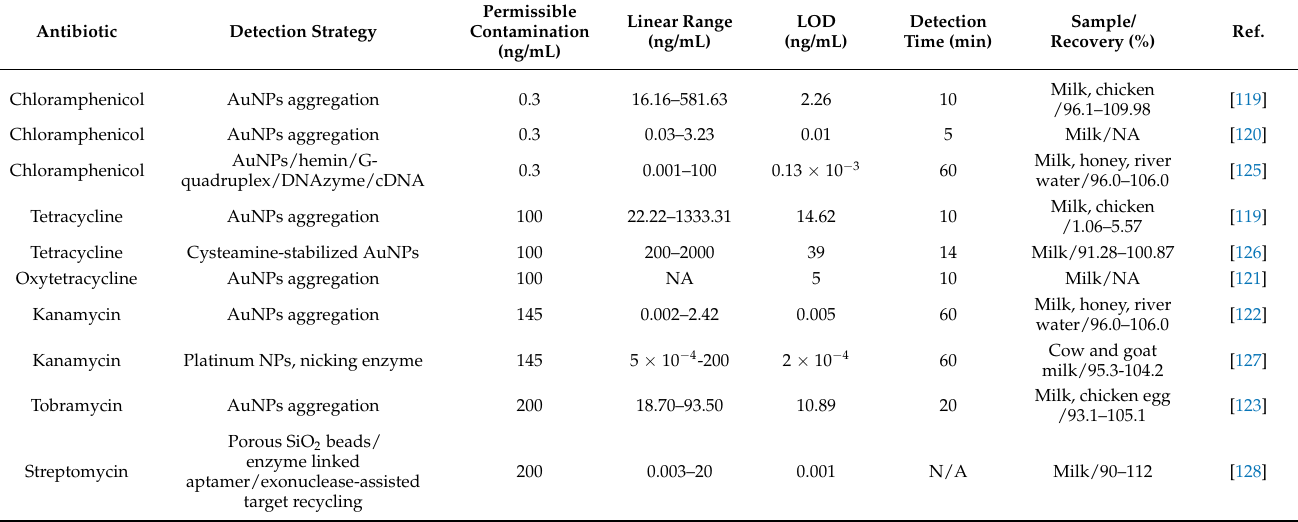
Table 4. Representative examples of the colorimetric assay for antibiotic detection and maximal permissible contamination values according to European Union regulations. Partially adopted from Majdinasab et al. [124] with permission of Elsevier, copyright 2020. NA—not